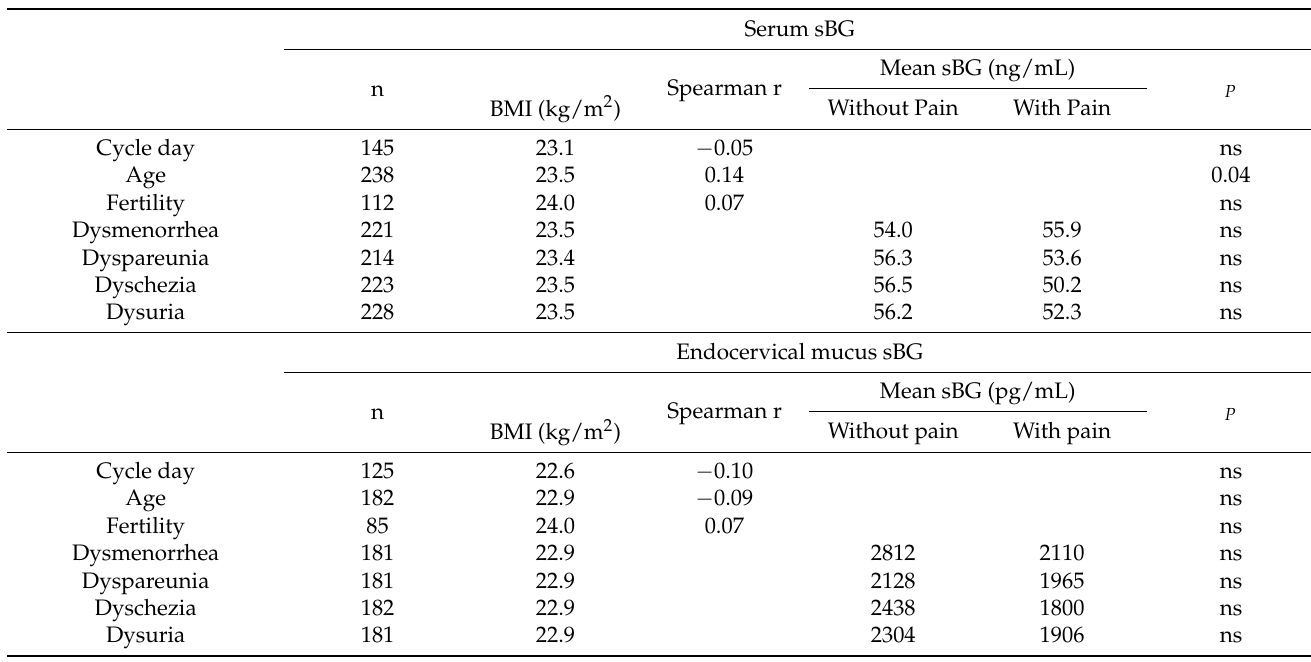
Table 5. Correlations of cycle day, age, fertility, and pain with serum and endocervical mucus sBG levels. Serum